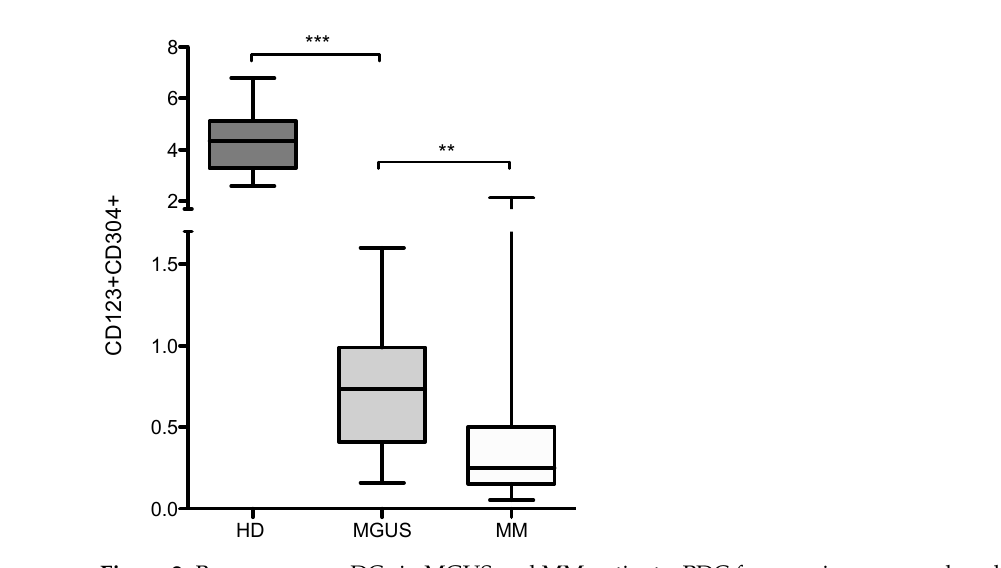
Figure 2. Bone marrow pDCs in MGUS and MM patients. PDC frequencies were analyzed in bone marrow (BM) in healthy donors (HD), MGUS and myeloma patients (MM). Each box shows the median with min and max values. Significant reductions of pDCs were determined as *** p < 0.0001 and ** p = 0.004 using the non-parametric Mann–Whitney test.